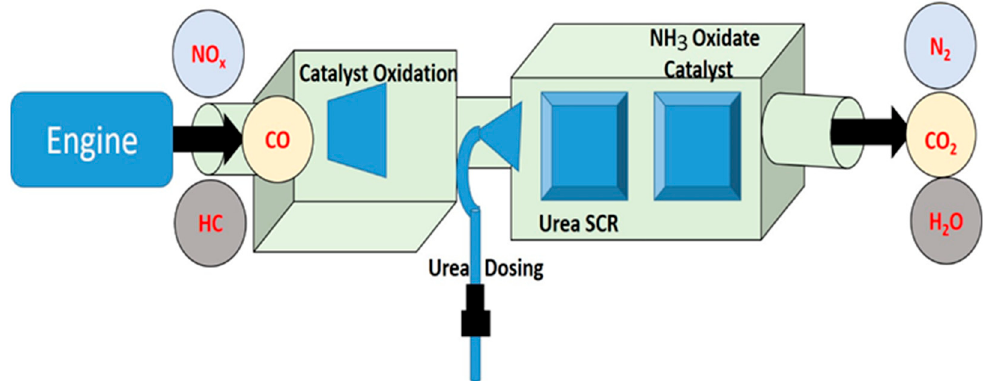
Figure 10. Schematic setup for selective catalytic reduction of exhaust emission in an internal combustion engine.